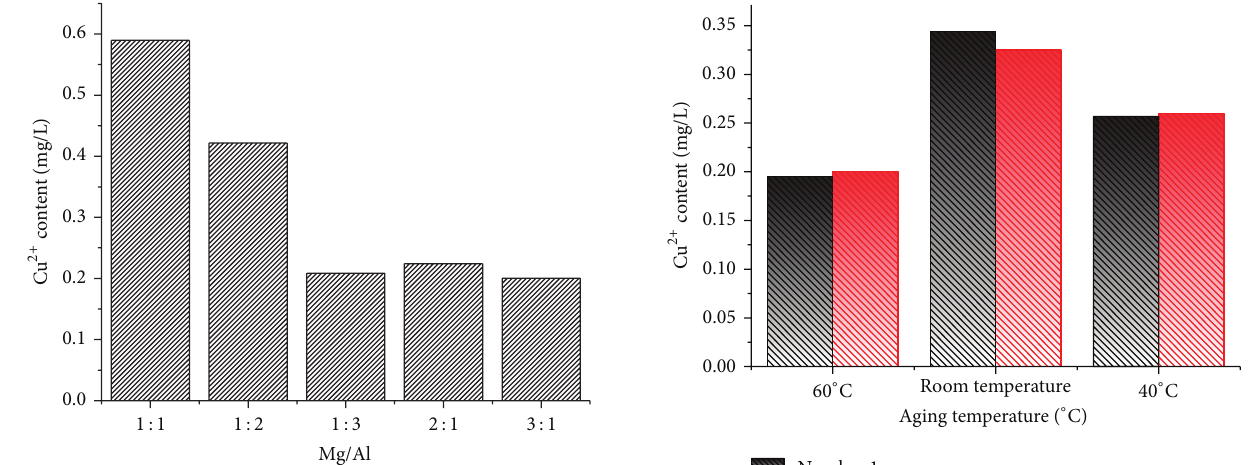
Figure 3: Effect of magnesia-alumina molar ratio on removal of copper.